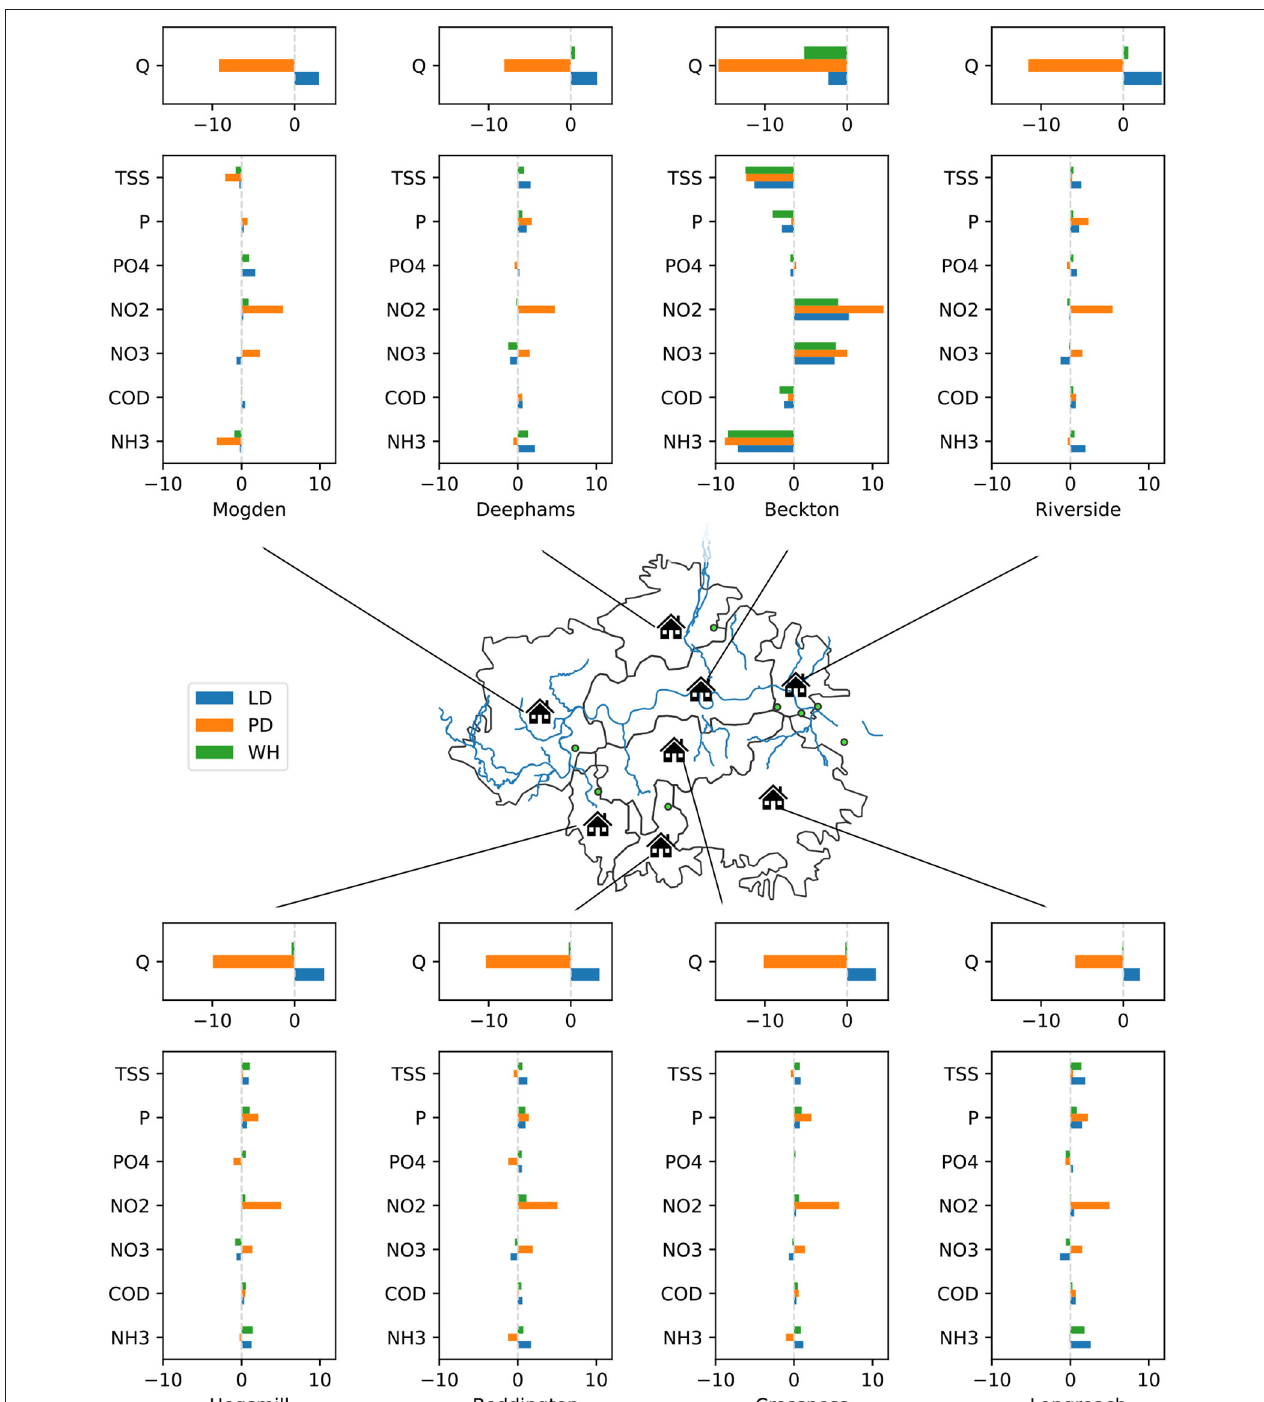
FIGURE 10 | Map depicting percentage changes in household wastewater flow and pollutant concentration (these are the bars). LD stands for the lockdown scenario, PD stands for the population decrease scenario and WH stands for the work from home scenario.